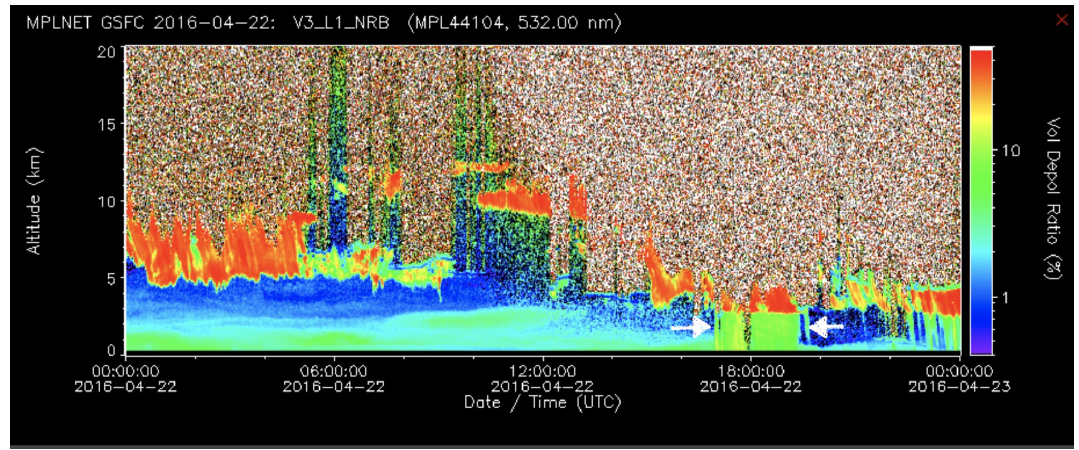
Figure 2. Precipitation event detected on 22 April 2016. With respect to ( a ) NRB, the precipitation on ( b ) VDR has more defined and sharp contours. The precipitation under the cloud (in red) has a different green tone. For this reason, the detection is easier on ( b